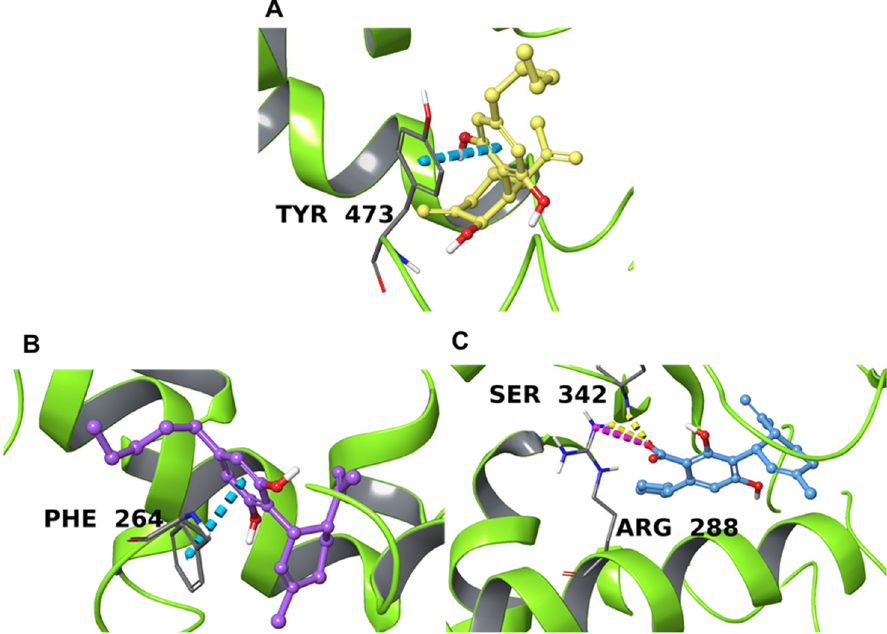
Figure 4. Binding poses of 1 ( A ), 2 ( B ), and 3 ( C ) in the catalytic domain of PPAR γ (PDB 2ZK6 for 1 and 4PRG for 2 and 3 ) depicted with lime green ribbons. The hydrogen bonds are depicted as yellow dotted lines, the salt bridges with magenta dotted lines, and π - π stacking interactions as cyan dotted lines. Interacting residues are labeled.